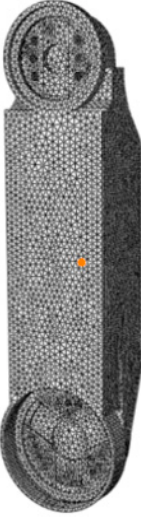
Figure 16. Material filling.